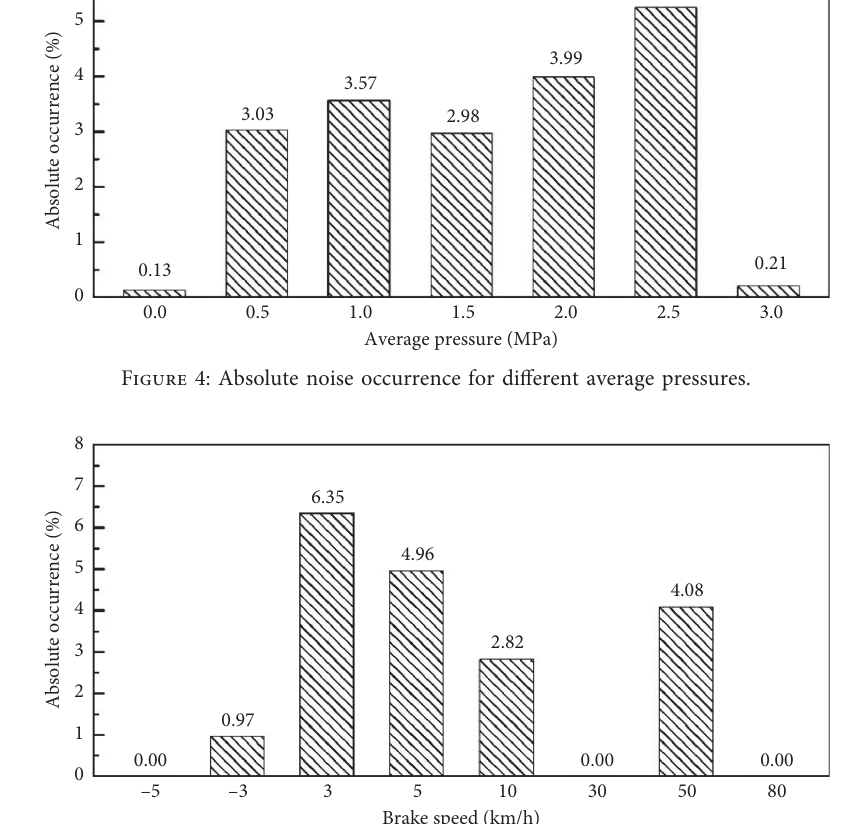
Figure 5: Absolute noise occurrence for different brake